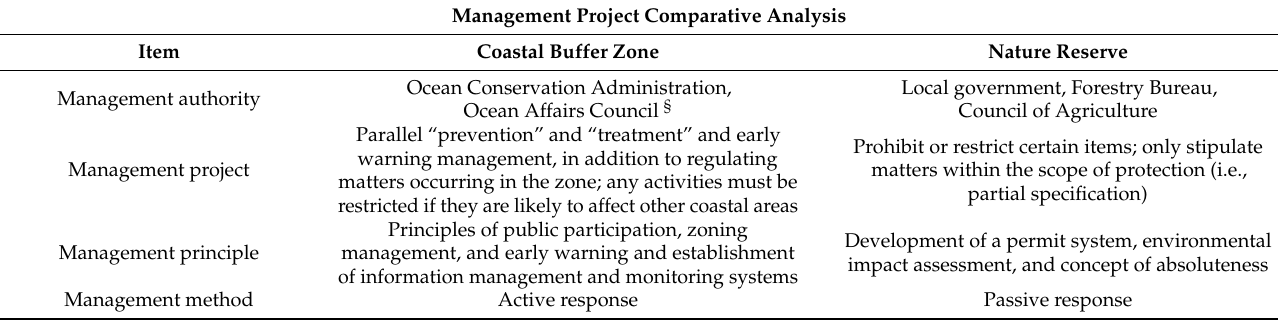
Table 2. Management project comparative analysis of coastal buffer zone and nature reserve (Howmeiliao Coast, Chiayi, Taiwan) (based on Lan et al.